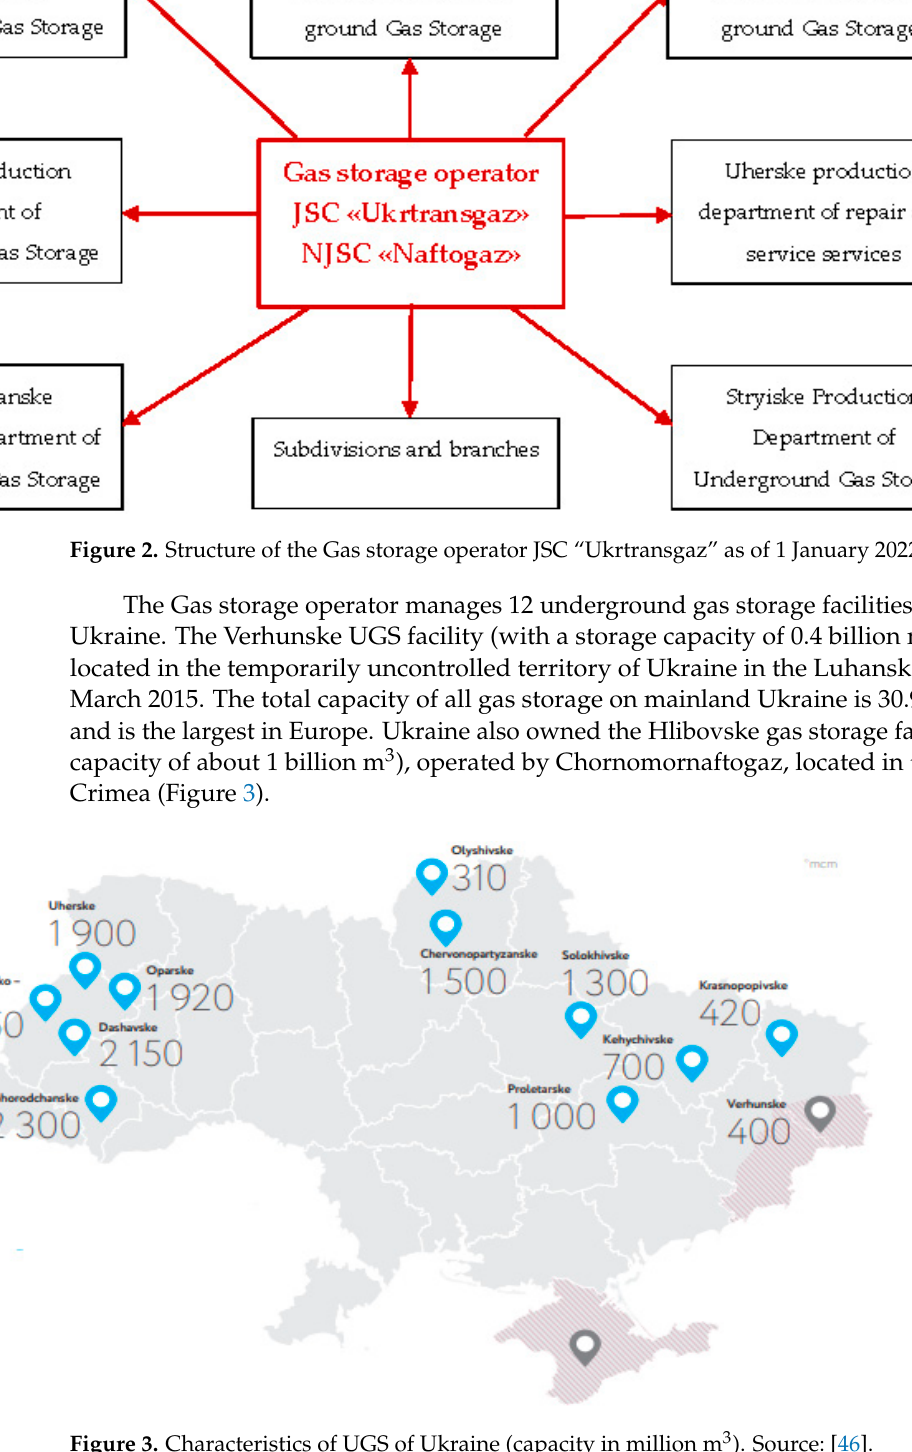
Figure 4. Characteristics of the maximum capacity of UGS of Ukraine during gas injection/with- drawal. Source: [32]. The Bilche-Volytske UGS facility is the largest not only in Ukraine but also in Europe and can hold 17 billion m 3 of gas, while the total capacity of other fields in Western Ukraine is about 2 billion m 3 . As for the daily capacity, the Bilche-Volytske UGSF has 18 million m 3 more injection than the withdrawal, while Bohorodchanske UGS, on the con- trary, has a daily withdrawal that exceeds the injection volume by 24 million m 3 . In Cher- vonopartyzanske, Solokhivske, and Kehychivske UGS facilities, the daily withdrawal vol- ume exceeds the injection volume, and vice versa in Krasnopopivske and Verhunske UGS